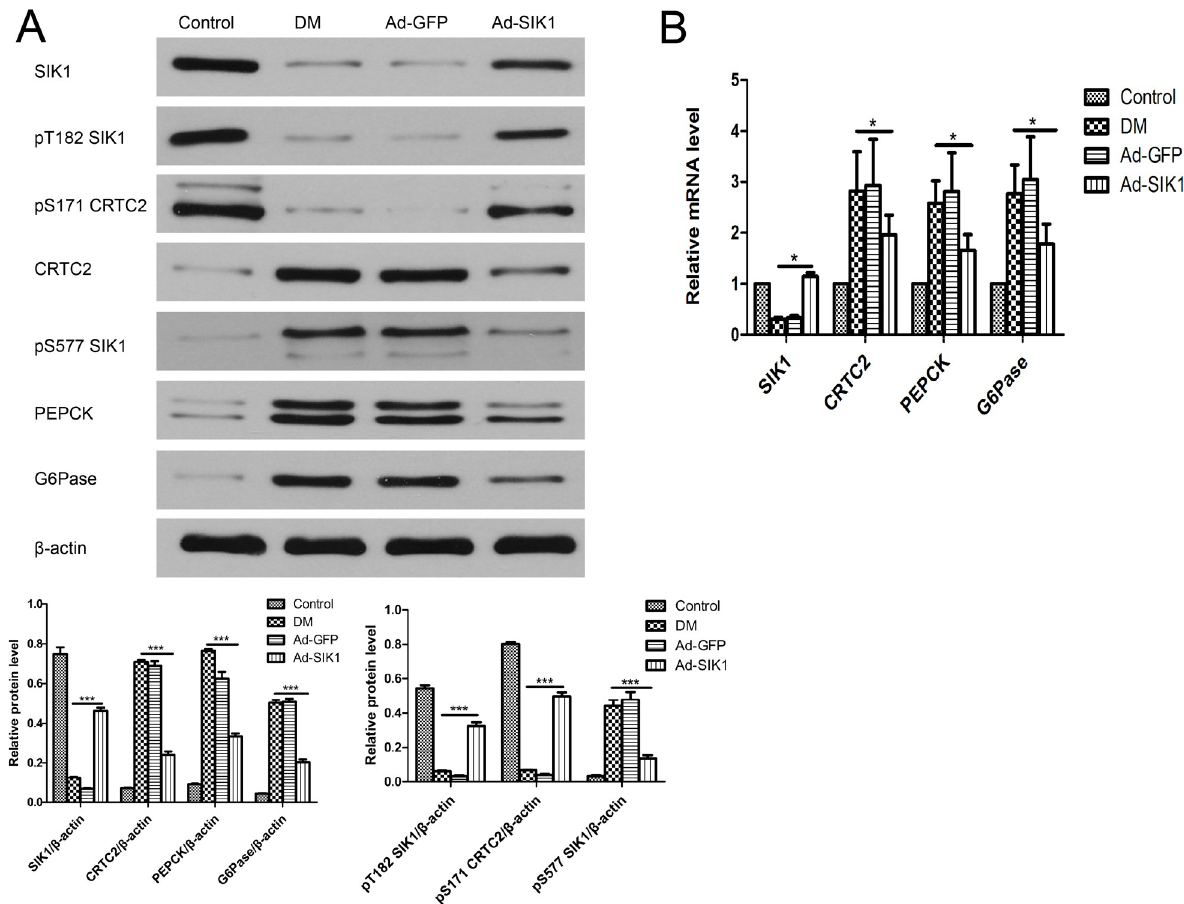
Fig 4. Effects on mRNA and protein expression of genes related to glucose metabolism in diabetic rats. (A) Protein levels of SIK1, CRTC2, PEPCK and G6pase in liver; (B) mRNA levels of SIK1, CRTC2, PEPCK and G6pase in liver. Fold expression levels were measured relative to the expression of β -actin (internal control). Data are presented as the mean ± SD. Significant differences are indicated as � p < 0.05, �� p < 0.01, ��� p < 0.001. ns, not significant. n = 6 in the control group; n = 5 in the DM group; n = 5 in the Ad-GFP group; n = 6 in the Ad-SIK1 group. Control, non-diabetic control rats fed a normal diet; DM, untreated HFD/STZ-induced diabetic rats; Ad-GFP, HFD/STZ-induced diabetic rats treated with Ad-GFP; Ad-SIK1, HFD/STZ-induced diabetic rats treated with Ad-SIK1.